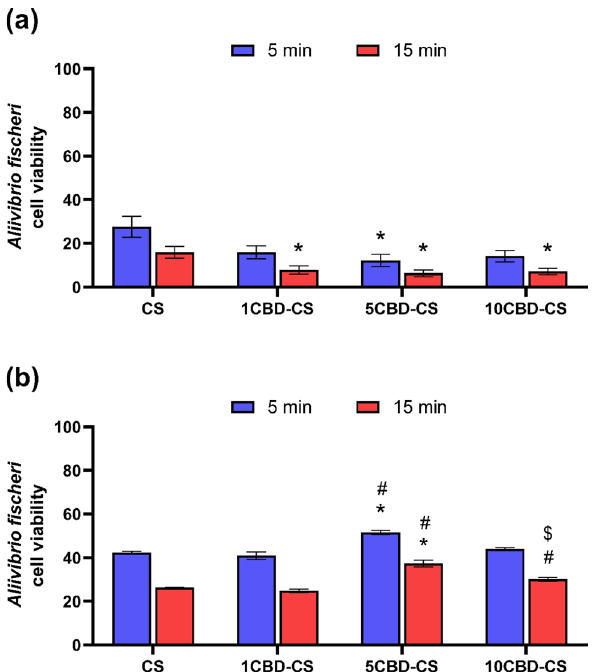
Figure 7. Changes in the A . fischeri viability after 5 and 15 min upon exposure to ( a ) the intact fragments of the prepared films and ( b ) the film’s suspension in water. 1, 5, 10CBD-CS corresponds to the weight ratio of 1, 5 or 10% of cannabidiol oil (CBD) to chitosan (CS). *, #, $ indicate p < 0.05 when compared to the corresponding CS, 1CBD-CS and 5CBD-CS,